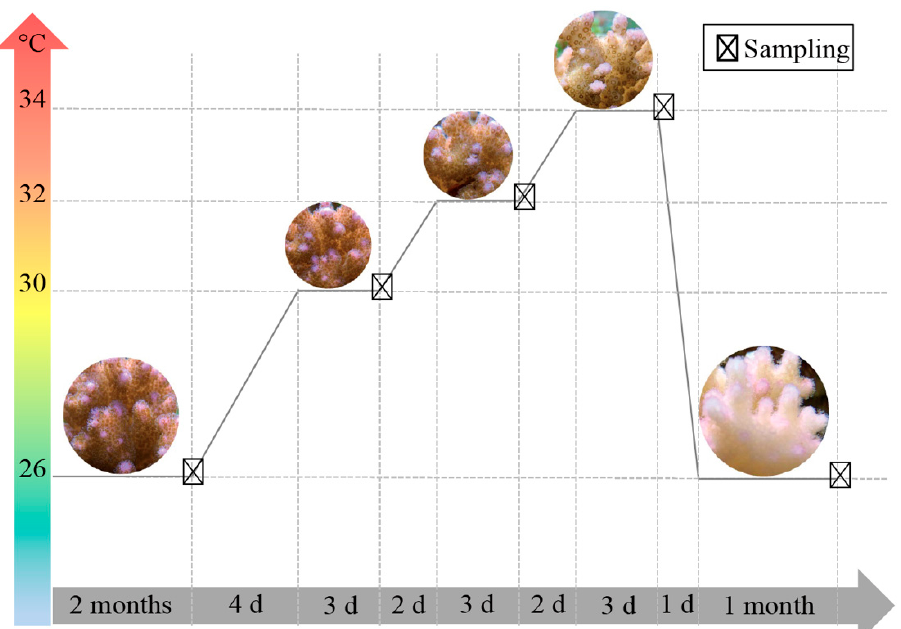
Figure 1. Heat treatment and sample collection. The horizontal line represents the time of the exper- iment. The symbol ☒ represents the sampling point at different temperatures (polar coordinates). experiment. The